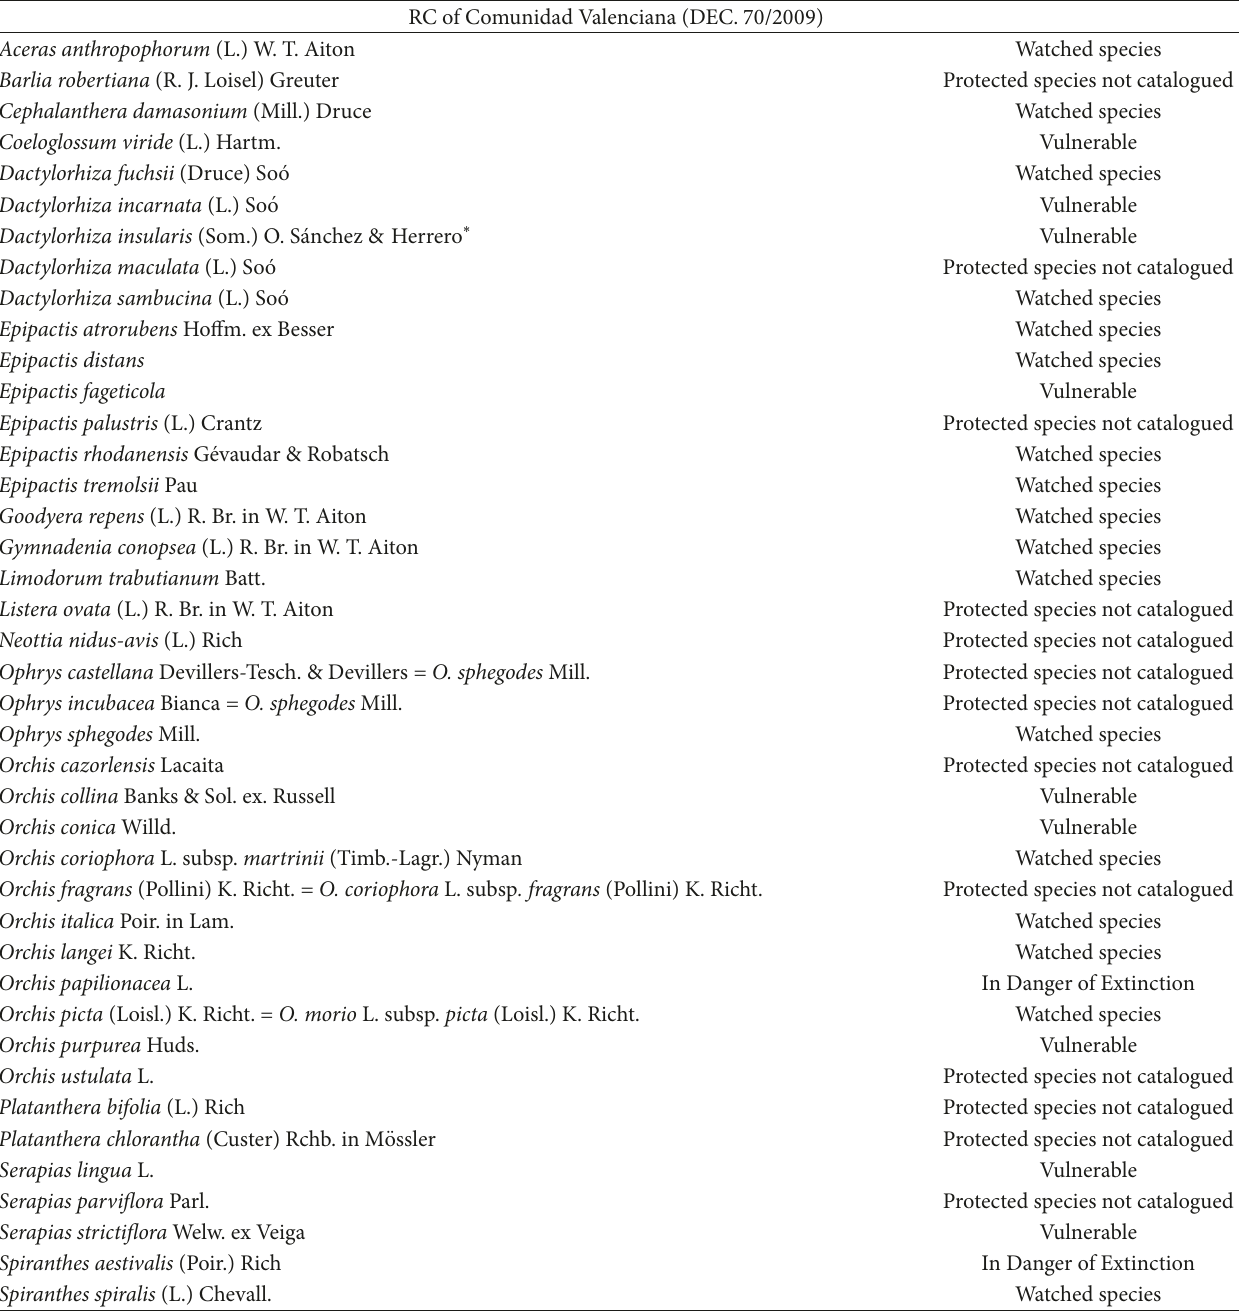
Table 14: Species included in the regional catalogue (RC) of Comunidad Valenciana (DEC. 70/2009). RC of Comunidad Valenciana (DEC.